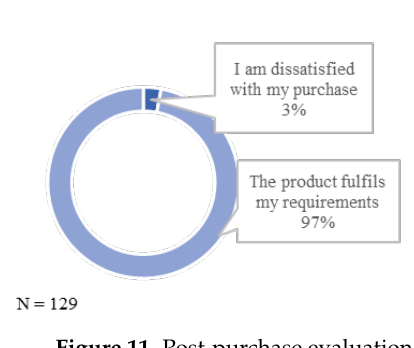
Figure 11. Post-purchase evaluation.